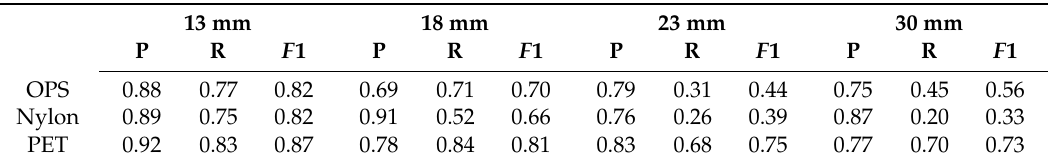
Table 4. The effect of spatial resolution (mm) on ResUNet50 performance (where P, R, F 1 are precision, recall, and F 1-score respectively) (Dataset 2).